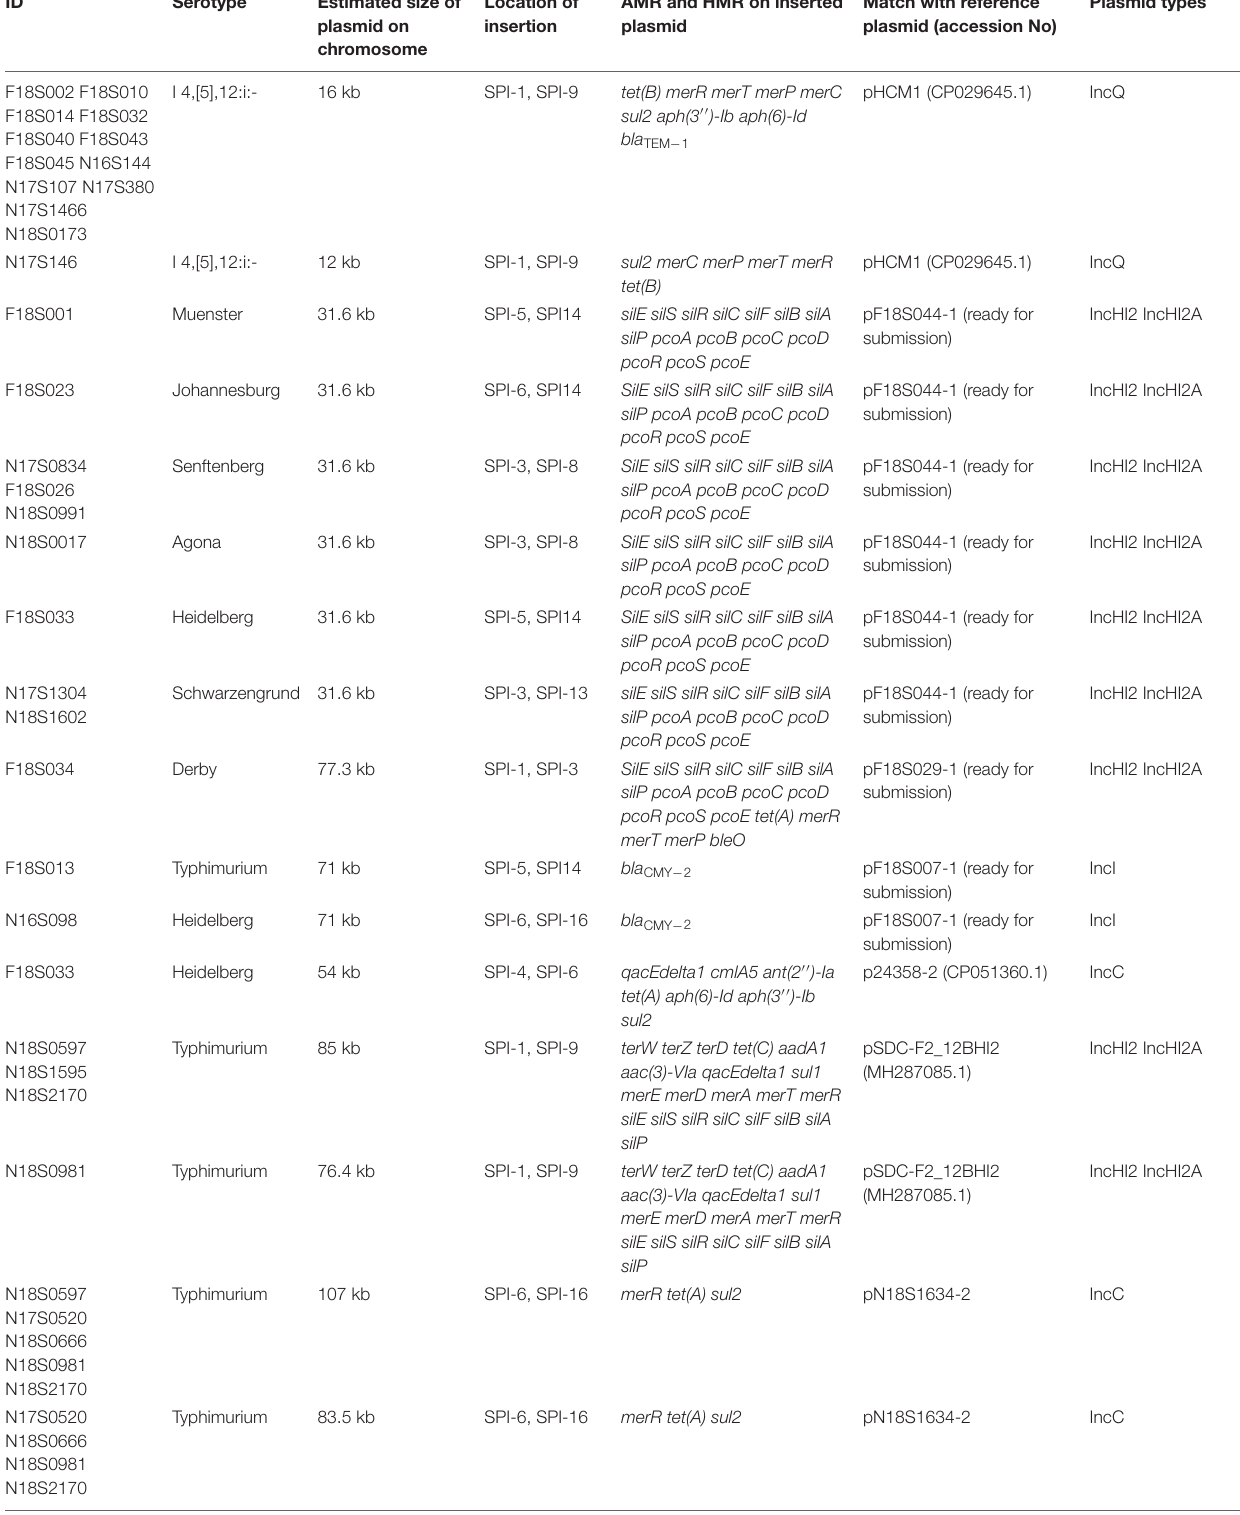
TABLE 2 | Putative integrated plasmids in Salmonella